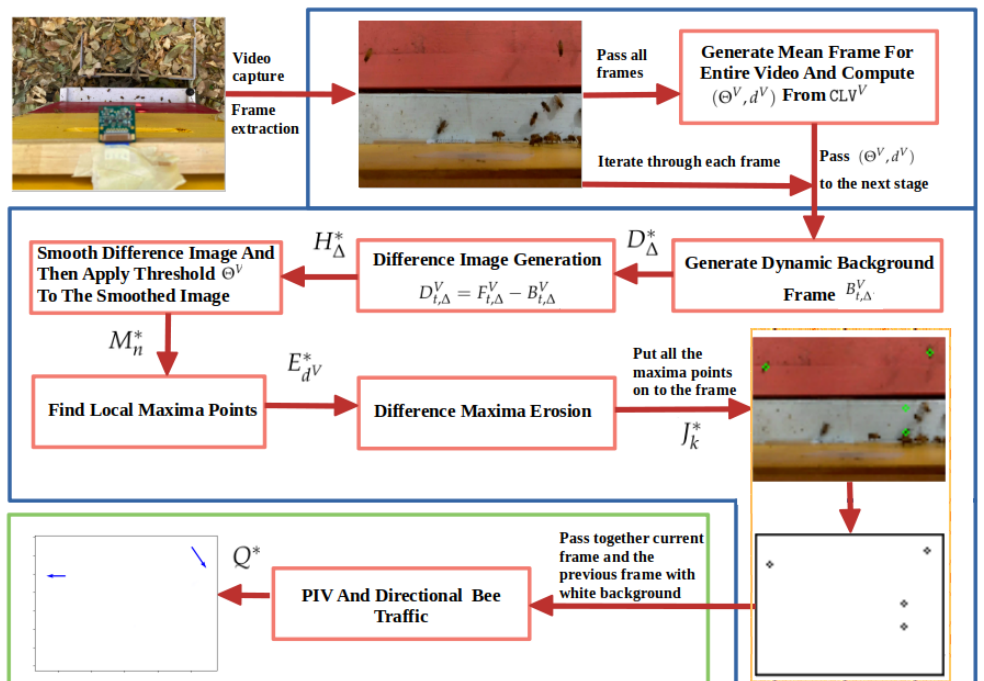
Figure 15. Flowchart of